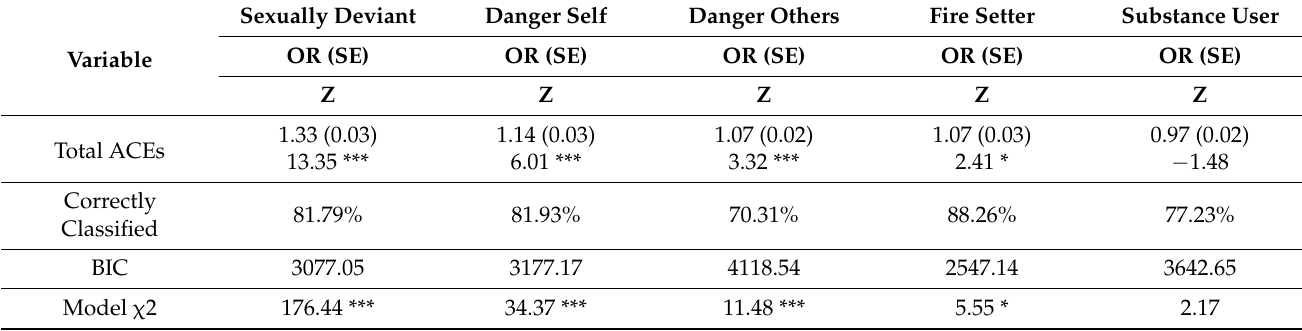
Table 1. Logistic Regression Models for Forensic Typologies for Total ACEs without Covariates.